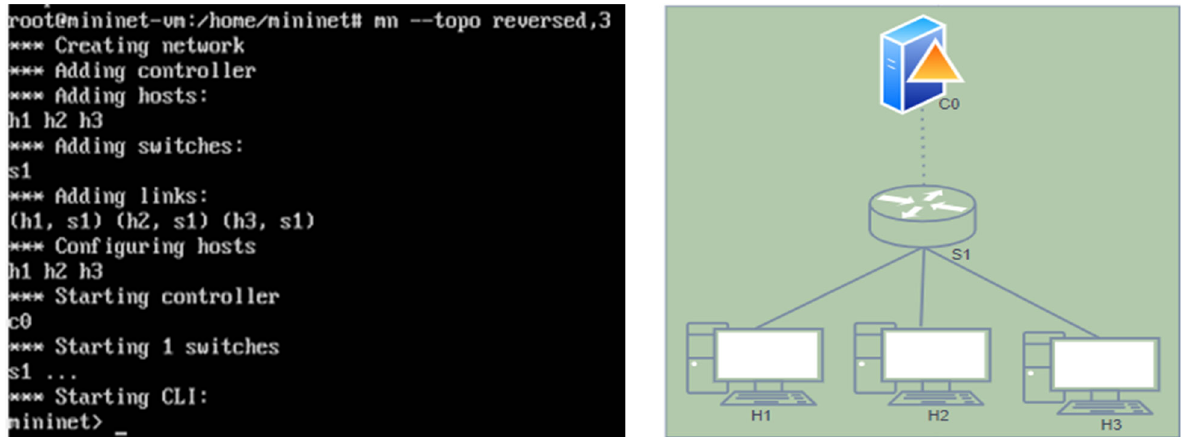
Figure 17. Tree topology Mininet command: mn ‐‐ topo tree,3.